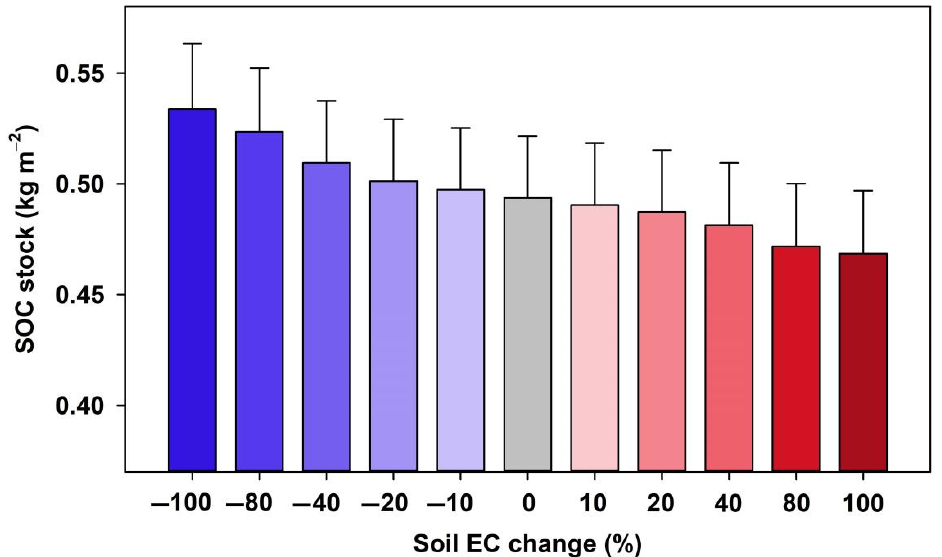
Figure 11. Area-weighted averages of SOC stock and standard deviations under different salinity change scenarios.